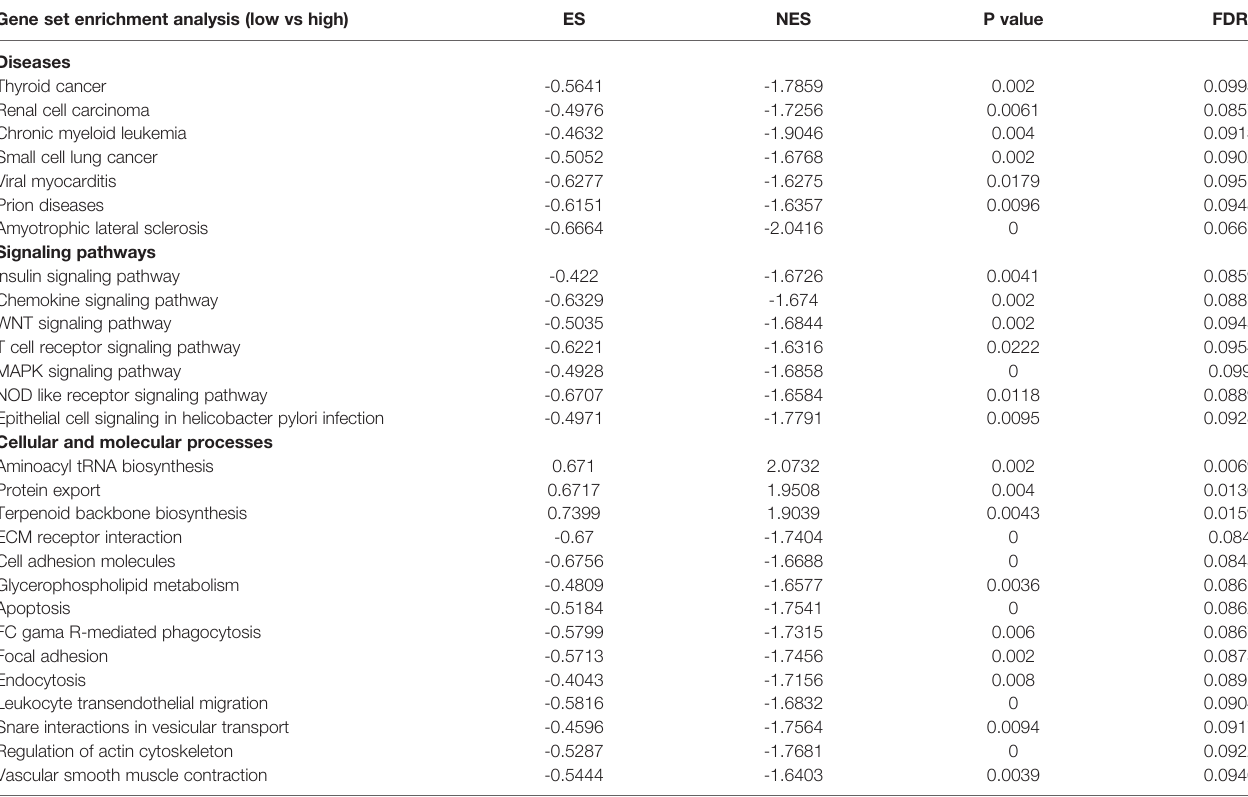
TABLE 2 | The results of gene set enrichment analysis between low- and high-risk group. Gene set enrichment analysis (low vs high)